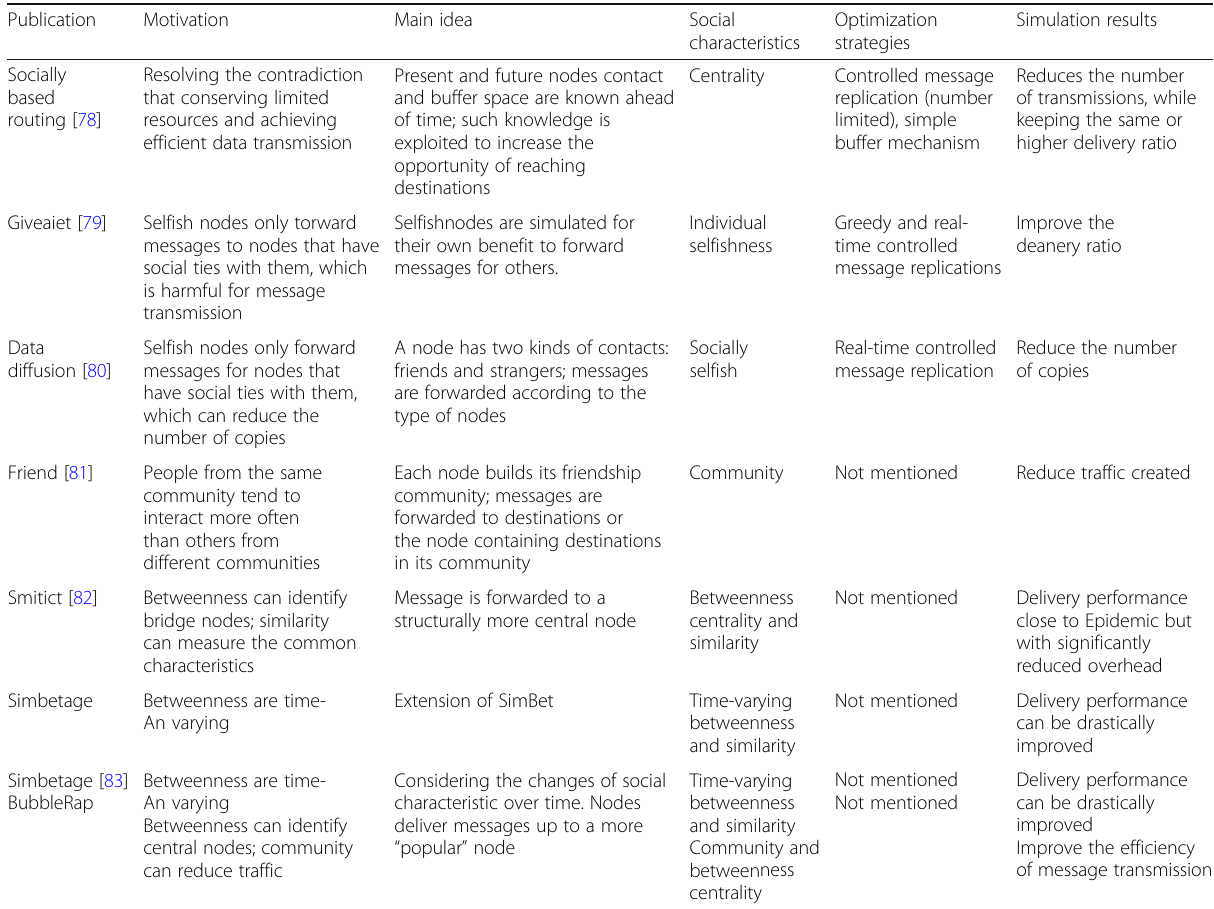
Table 4 Social-based routing